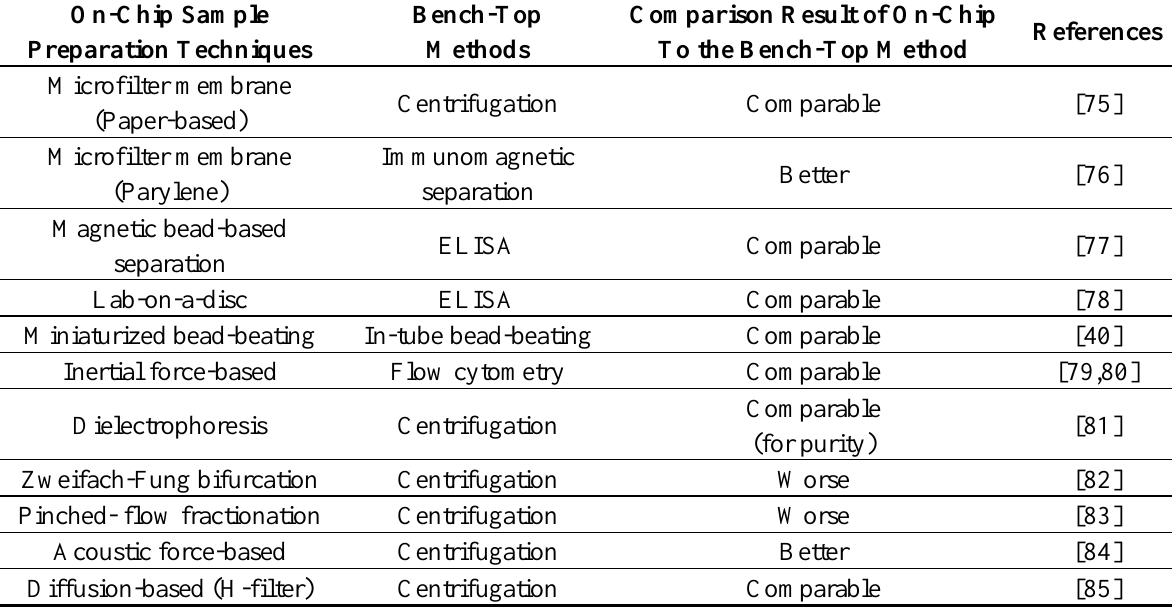
Figure 2. Summary of microfluidic-based sample preparation techniques that are classified into two groups: (1) those obtained by scaling down a macro-system and (2) utilization of micro-system phenomena. Table 3. Comparison between micro techniques to corresponding bench-top methods for sample preparation based on published